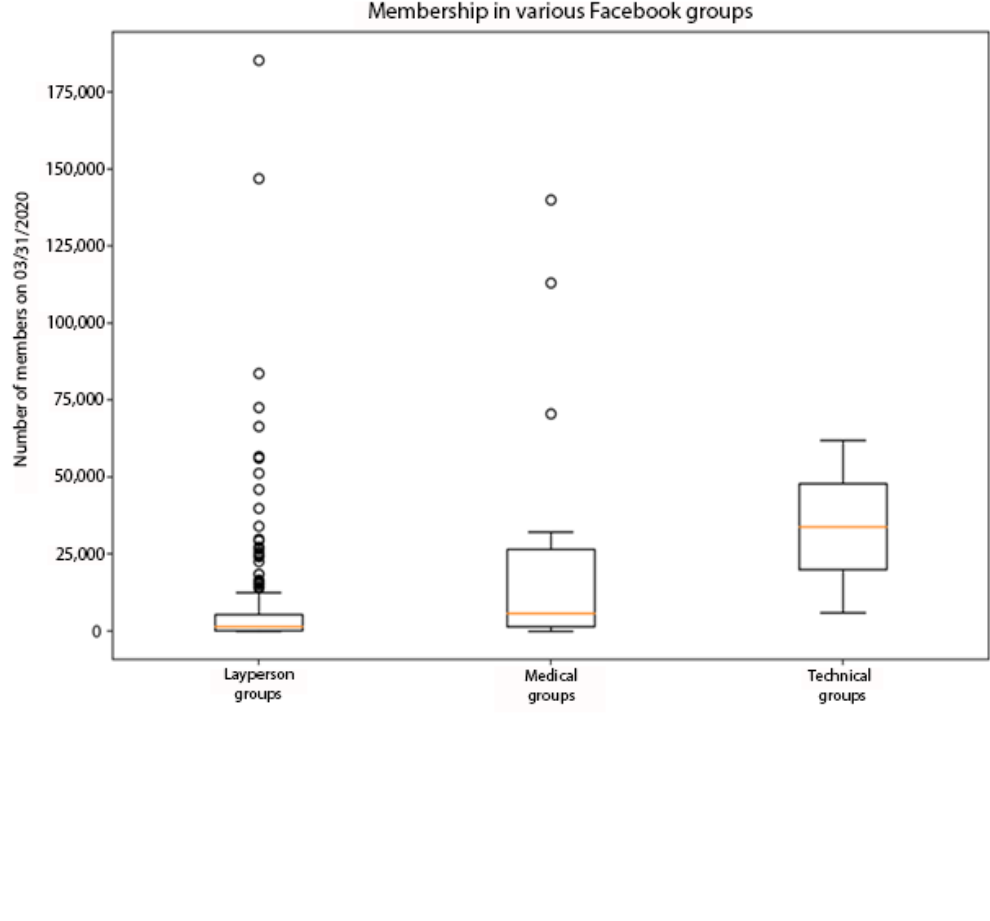
Figure 1. Characteristics of COVID-19–related Facebook groups by group